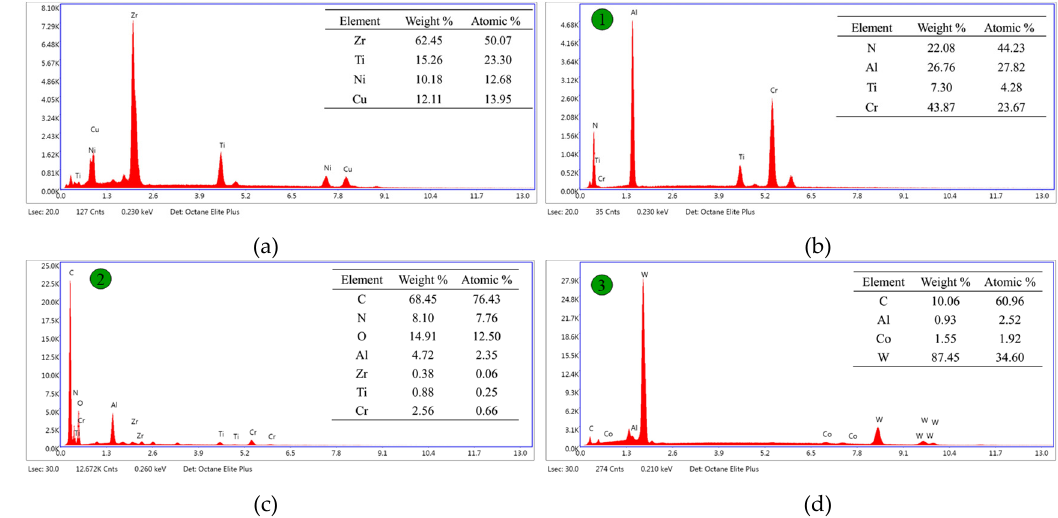
Figure 10. EDS (energy-dispersive spectroscopy) analysis results at different locations. ( a ) BMG workpiece; ( b ) location 1; ( c ) location 2; ( d ) location 3.